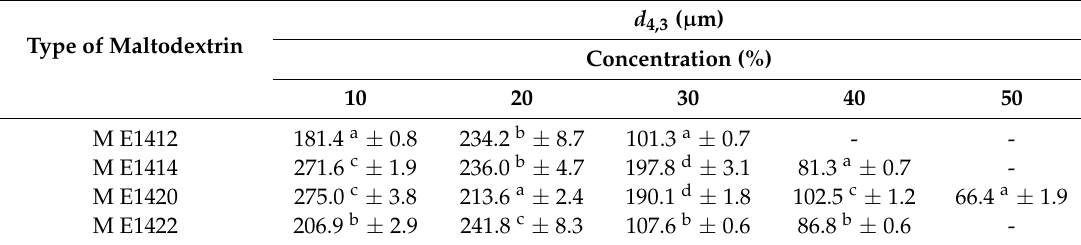
Table 2. Average diameter of oil droplets in freshly prepared emulsions stabilized by DE 6 maltodextrins solutions.